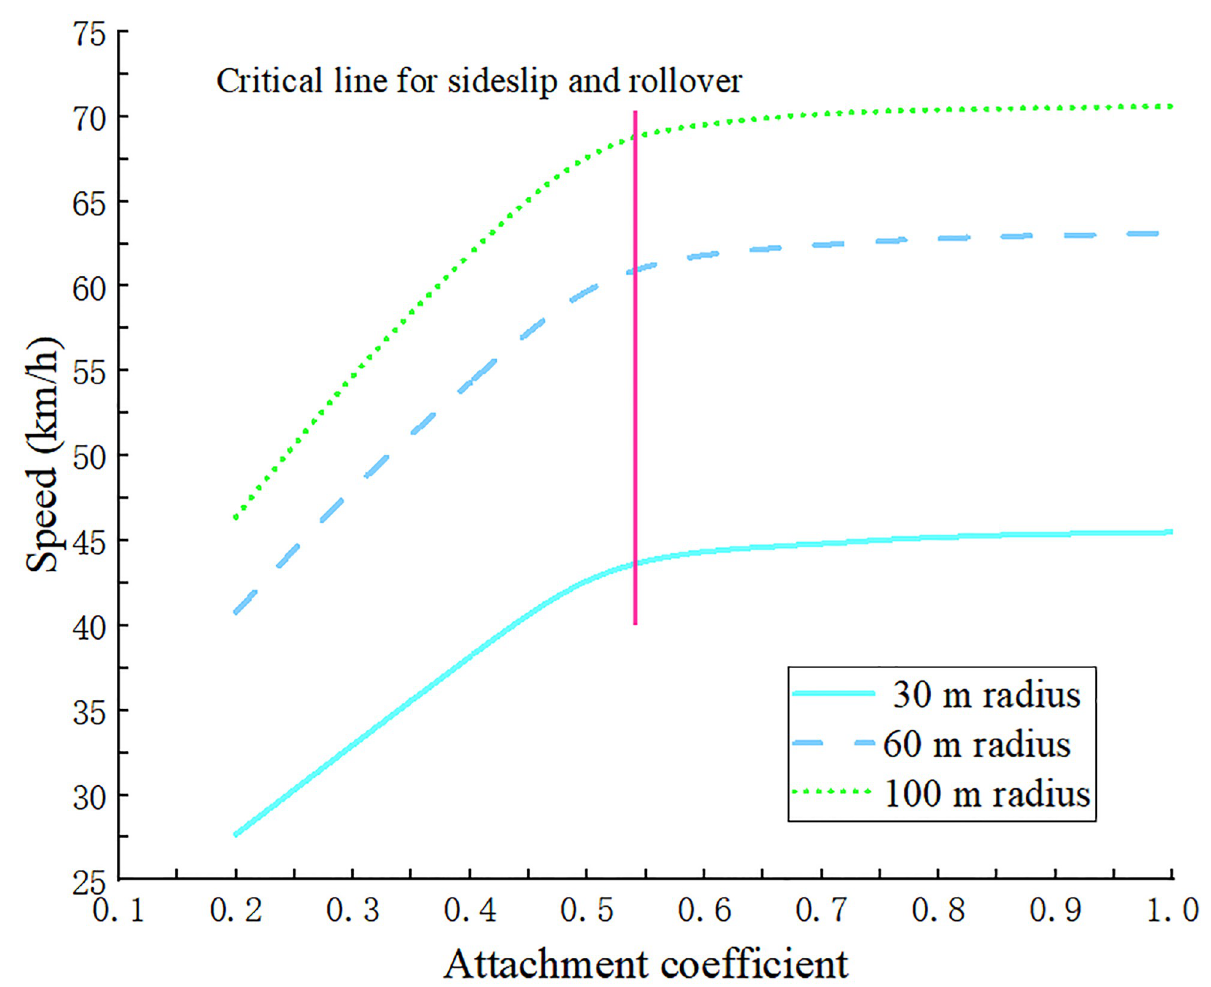
Fig 10. Curve of the instability speed of truck driving corresponding to different adhesion